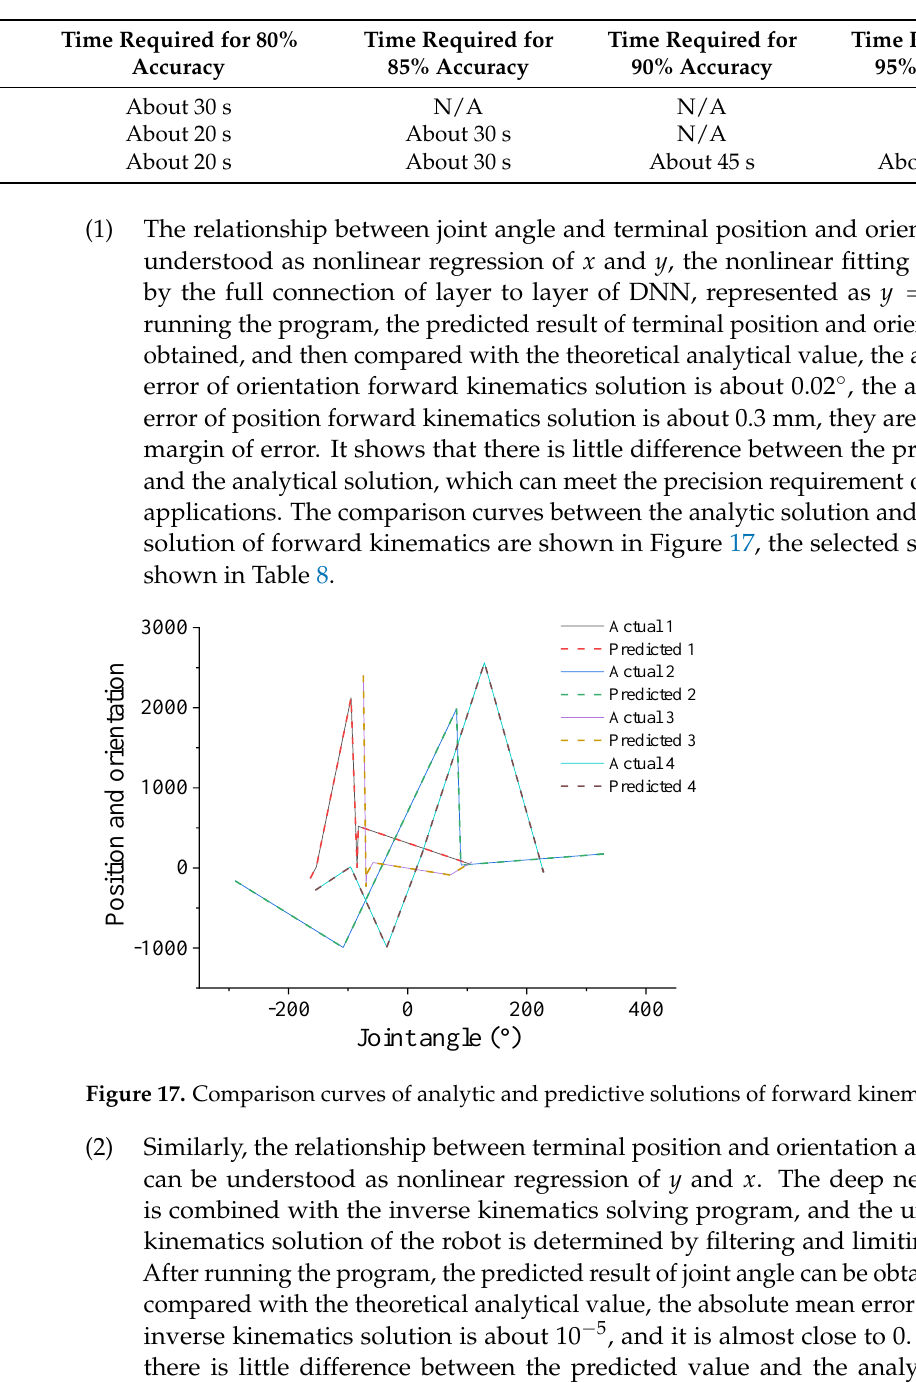
Table 7. The optimized time results and efficiency.